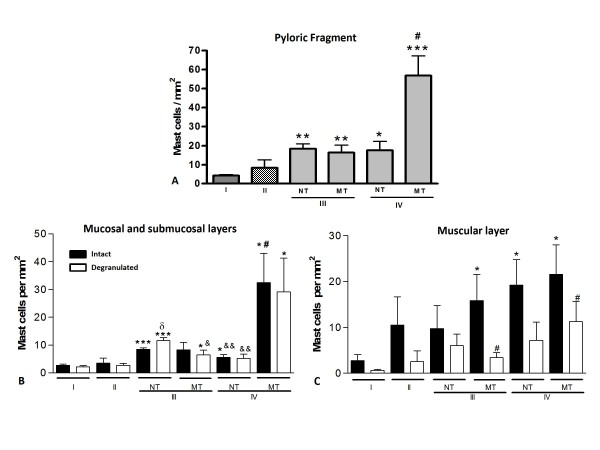
Quantitative analysis of mast cells in the stomach. Data represent the mean ± S.E.M of sixty fields analyzed per animal as described in Material and Methods. Non-denervated (I) and denervated stomach (II) without lesions. Non-denervated (III) and denervated stomach (IV) with lesions. Non-malignant tumor (NT). Malignant tumor (MT). A) Total number of mast cells in the gastric fragment. *P < 0.05 vs. group I. # P < 0.01 vs. another experimental groups. B and C) Intact and degranulated mast cells in the mucosal, submucosal and muscular layers. * P < 0.05 vs. group I; #P < 0.05 vs. another experimental groups; δ P < 0.05 vs. group III - NT (intact mast cells); &P < 0.05 vs. group III - NT (degranulated mast cells). C) Intact and degranulated mast cells in the muscular layer. *P < 0.05 vs. group I; # P < 0.05 vs. group II.